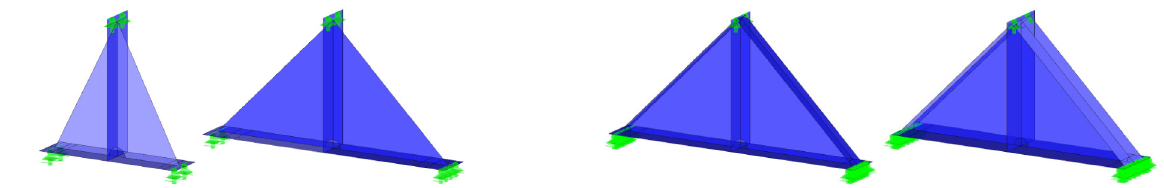
Fig. 8. Research FEA models of a haunch without a flange Fig. 9. Research FEA models of a haunch with a flange